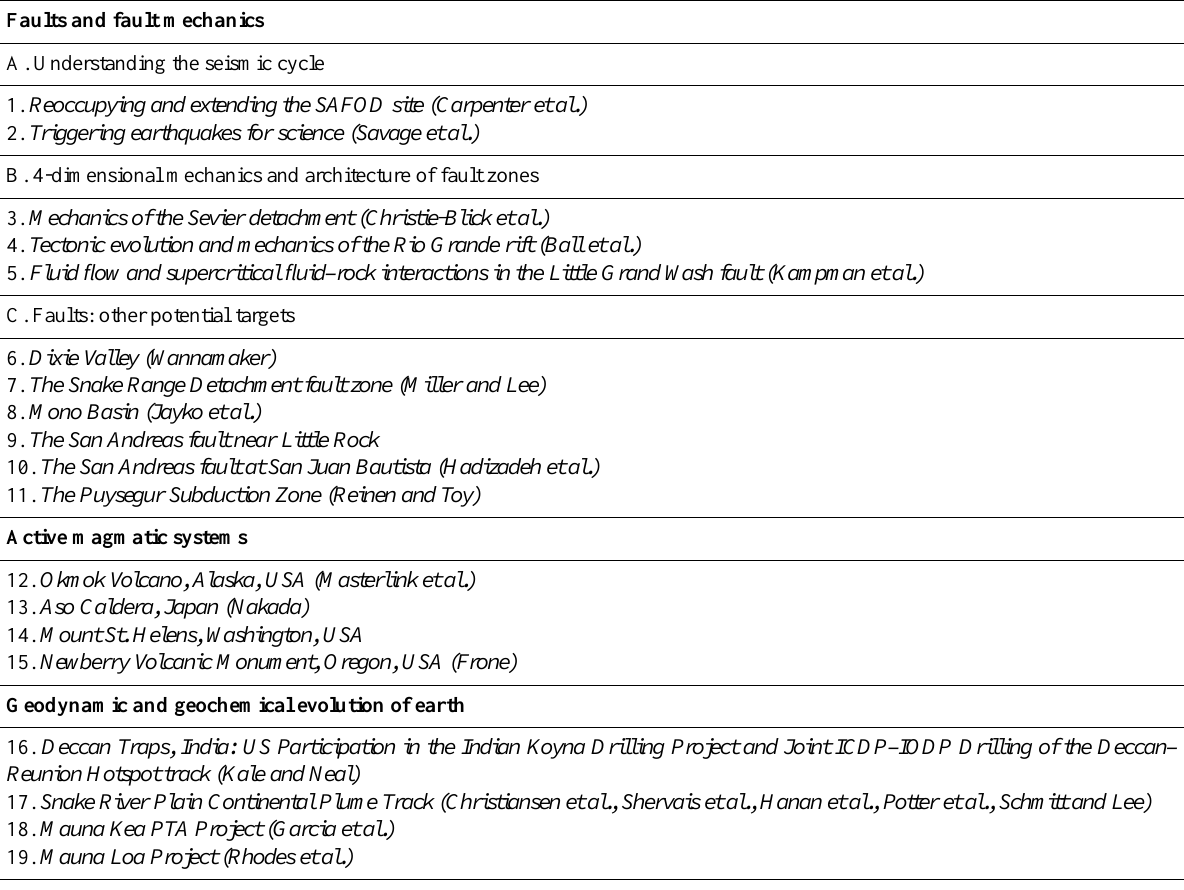
Table 2. Potential projects recommended by the participants, and other potential projects. Author(s) of relevant white paper listed in paren-